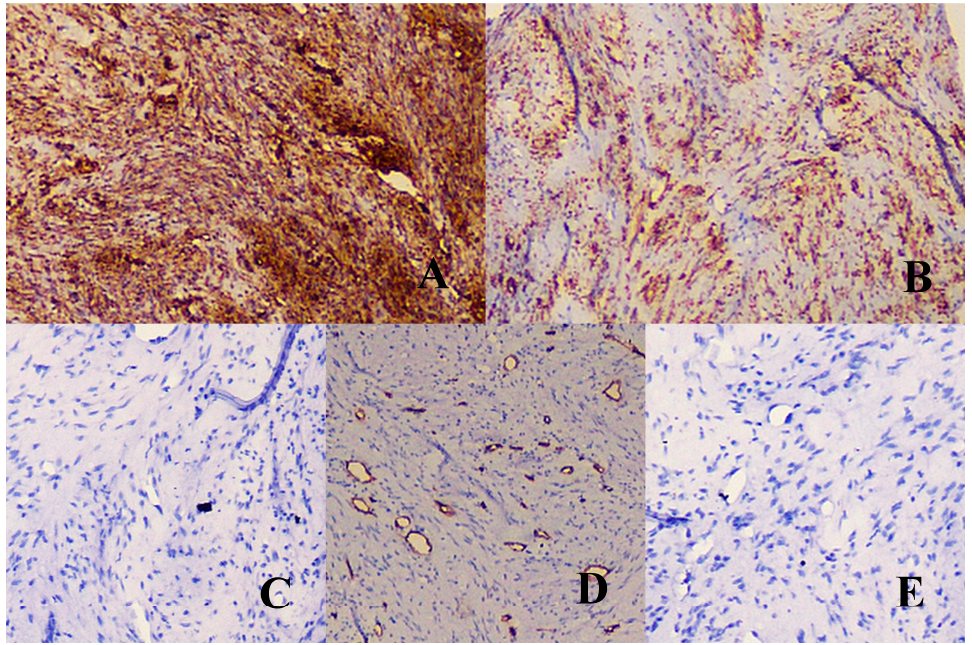
Figure 3. Immunohistochemical marker panel. ( A , B ) Tumor cells are positive for vimentin and alpha-smooth muscle actin ( α -SMA) markers, respectively. ( C , E ) Tumor cells are negative for S-100 and desmin markers respectively. ( D ) CD-34 marker is positive in the blood vessels but negative in the tumor cells.